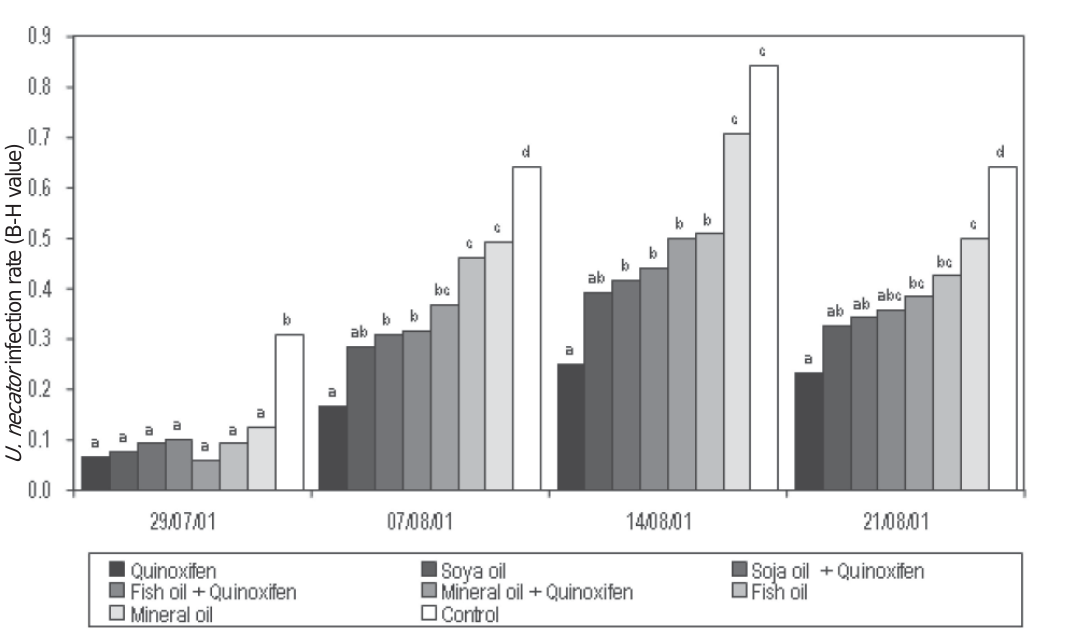
Fig. 3. Powdery mildew infection rate on leaves (Barrat-Horsfall scale) at different times after oil spraying, in a field